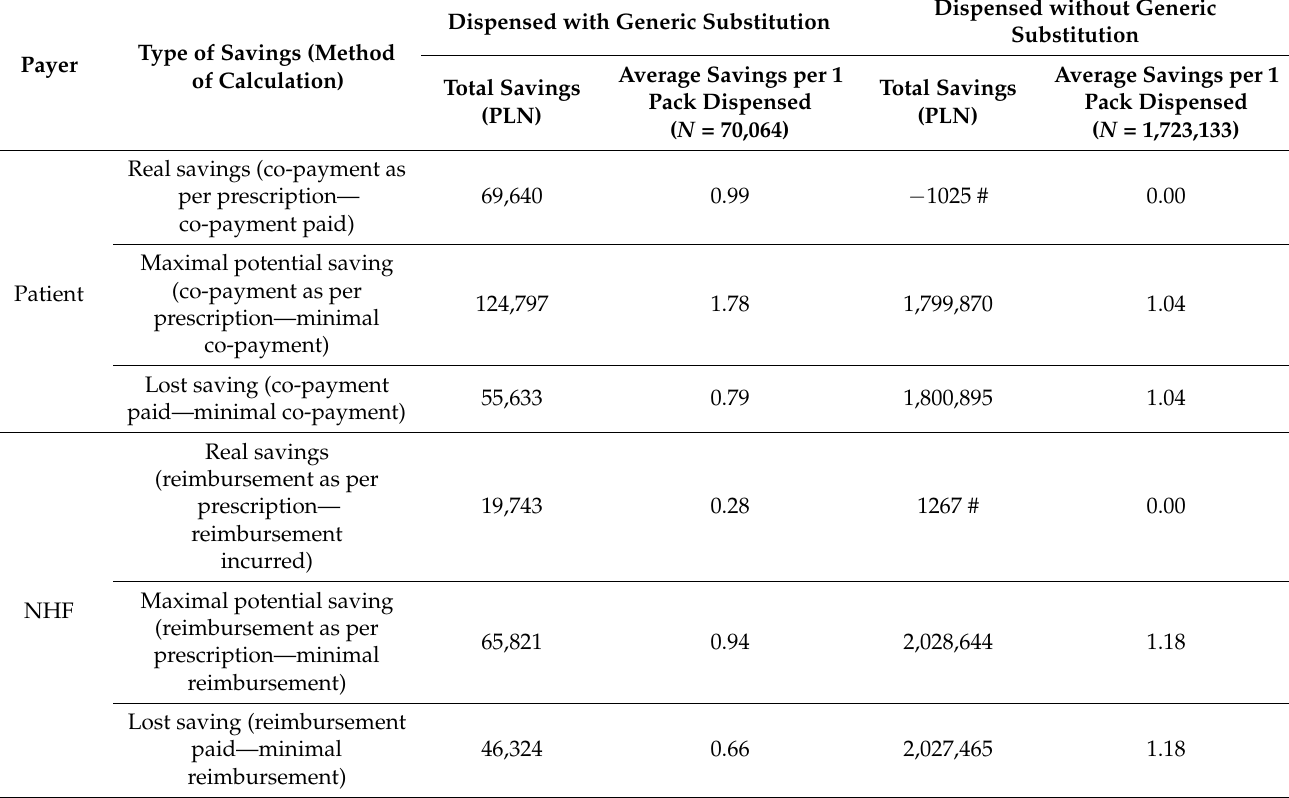
Table 3. Economic consequences of dispensing e-prescriptions for metformin preparations with and without generic substitution in Poland in 2019 (data refer to the dispensation period between 1 January–31 December 2019); # non-zero values resulting from the change of the reimbursement level between the date of prescribing and dispensation; NHF— National Health Fund; PLN—Polish